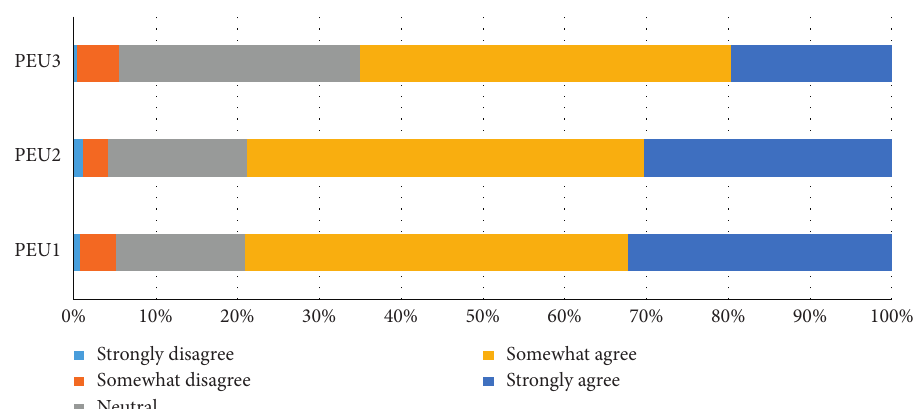
Figure 3: Percentage of perceived ease of use of